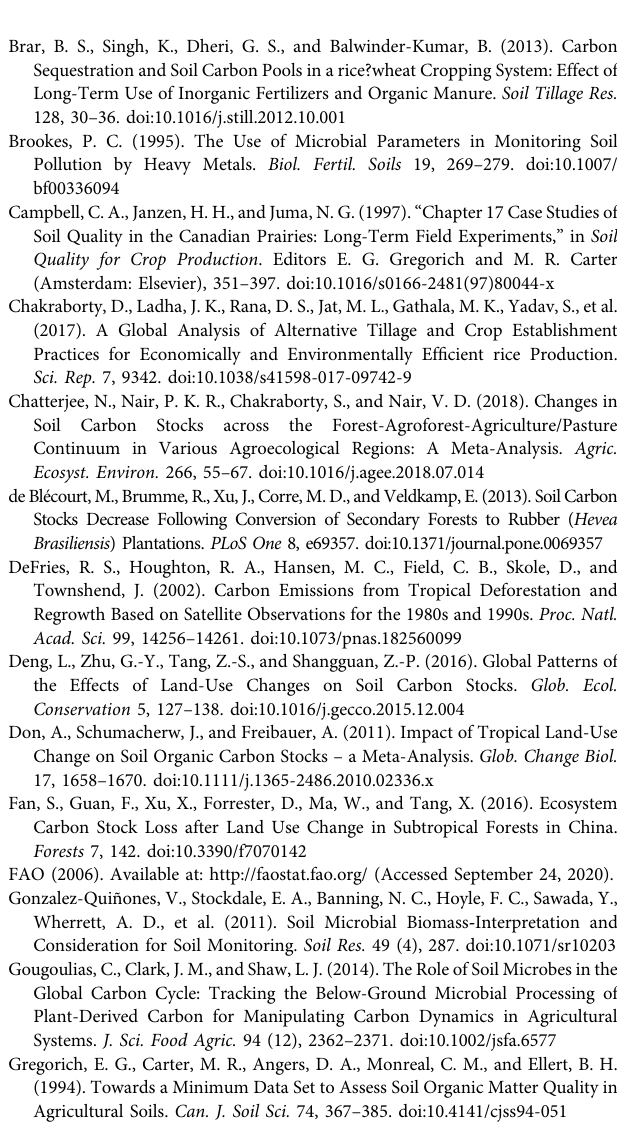
Supplementary Figure S1 | Trend of share of forest land (FL) in Y1-axis and cultivated land (CL) in Y2-axis area of total land (1990 – 2017) of India, FAO (http://faostat.fao.org/). Supplementary Figure S2 | Relationship between microbial biomass carbon (MBC, mg carbon/kg soil) and soil organic carbon (SOC, g carbon/kg soil) from the studies used in the study. Dotted lines indicate microbial quotient (MQ) of 2.5% and